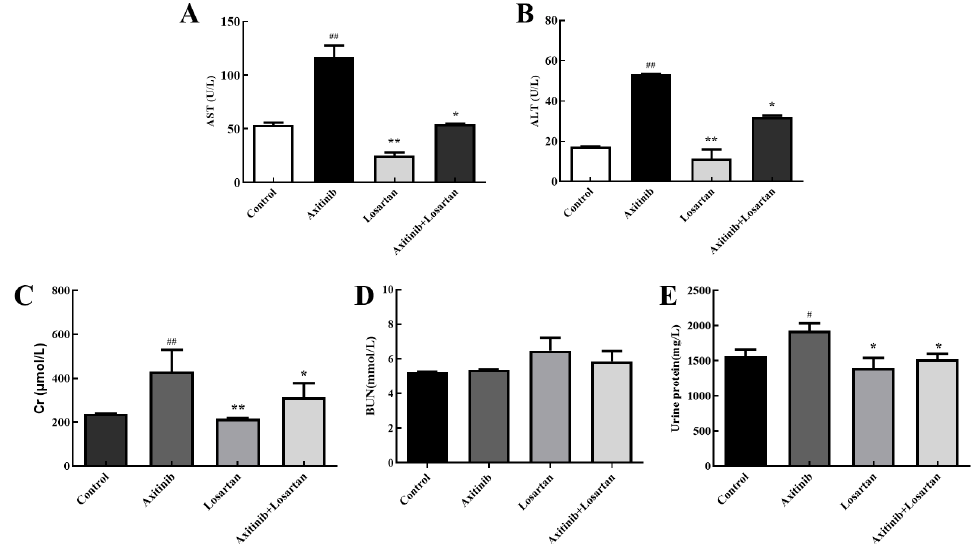
Figure 2. Effects of axitinib combined with losartan on the level of AST/ALT in rat serum and liver homogenate. ( A ) Effects of axitinib combined with losartan on the level of plasma AST in rats. ( B ) Effects of axitinib combined with losartan on the level of plasma ALT in rats. ( C ) Levels of plasma Cr in rats of experimental groups. ( D ) Effects of axitinib combined with losartan on the level of plasma BUN (blood urea nitrogen) in rats. ( E ) Levels of urine protein in rats of experimental groups. # p < 0.05 vs. control group, ## p < 0.01 vs. control group, * p < 0.05 vs. axitinib group, ** p < 0.01 vs. axitinib group.